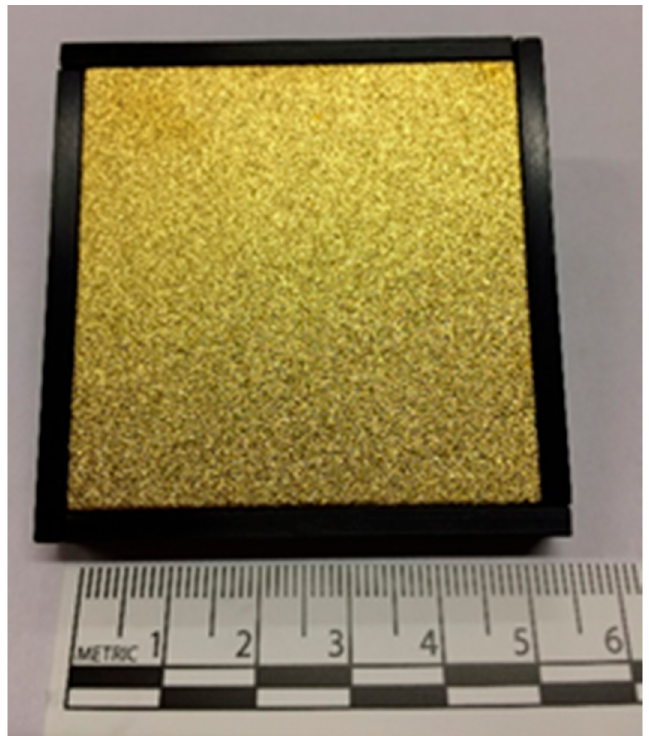
Figure A6. The Infragold reference standard used by UT-ITC for their calculation of reflectance.